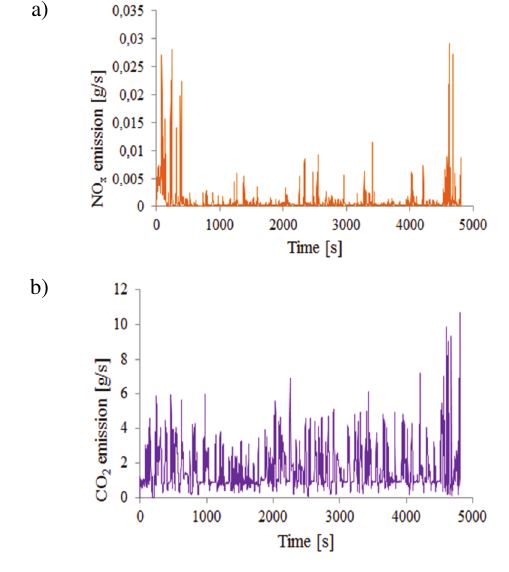
Fig. 5. Measured compounds emission per second: a) NO x , b) CO